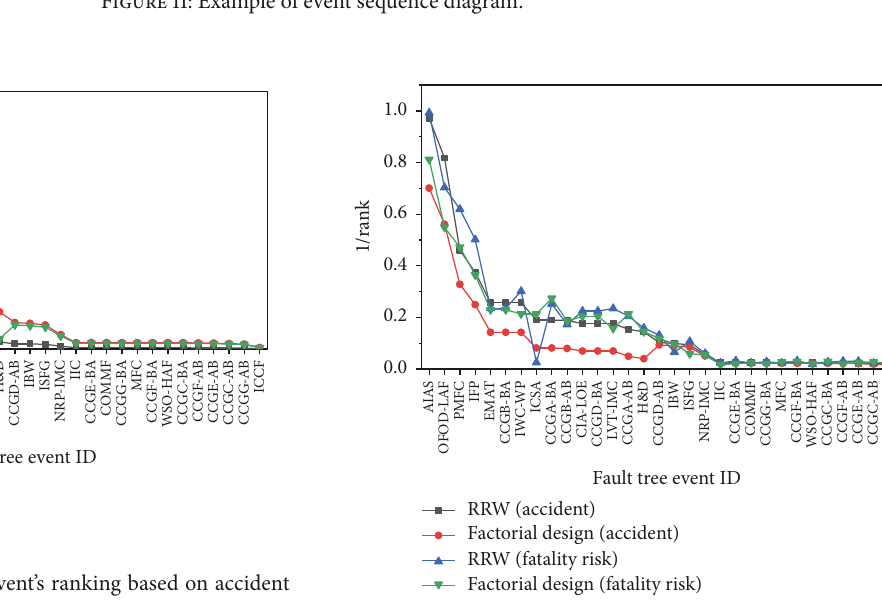
Figure 11: Example of event sequence diagram.